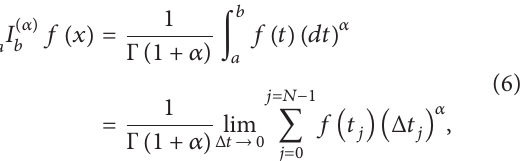
fractional integral operator [22–27], which are used in this paper.